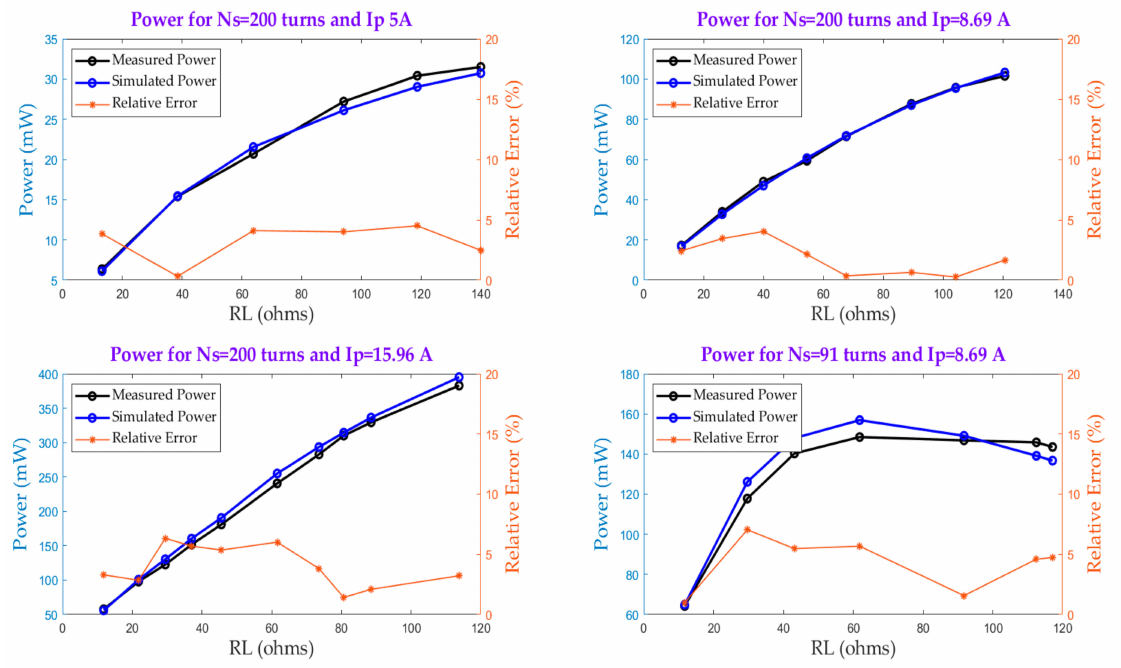
Figure 8. Verification of Model 1